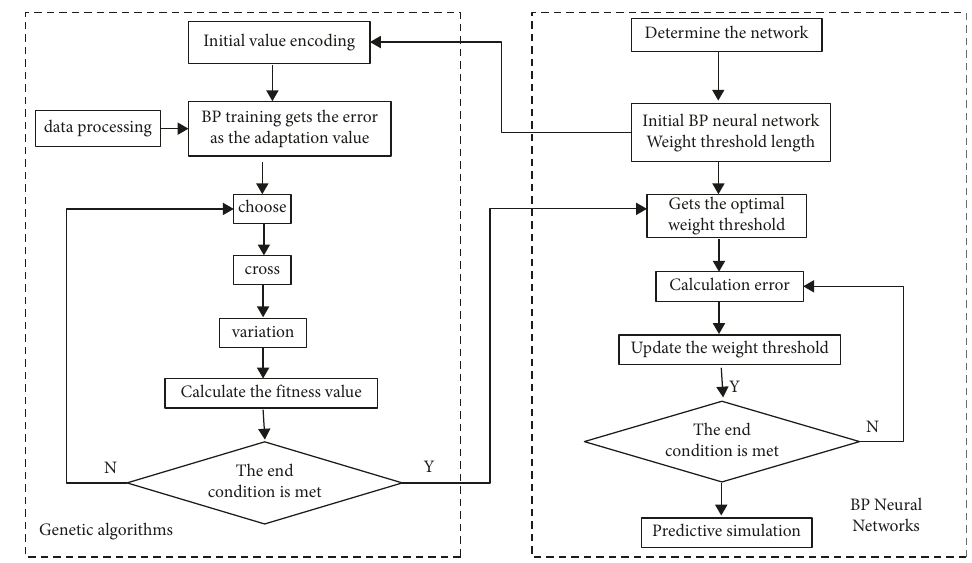
Figure 4: GA optimization-based BP.